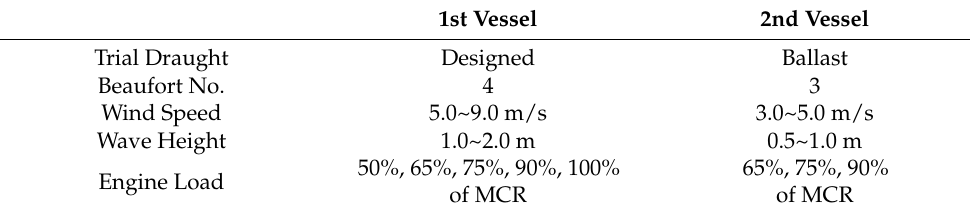
Table 1. Overview of the speed trials of crude oil tankers.